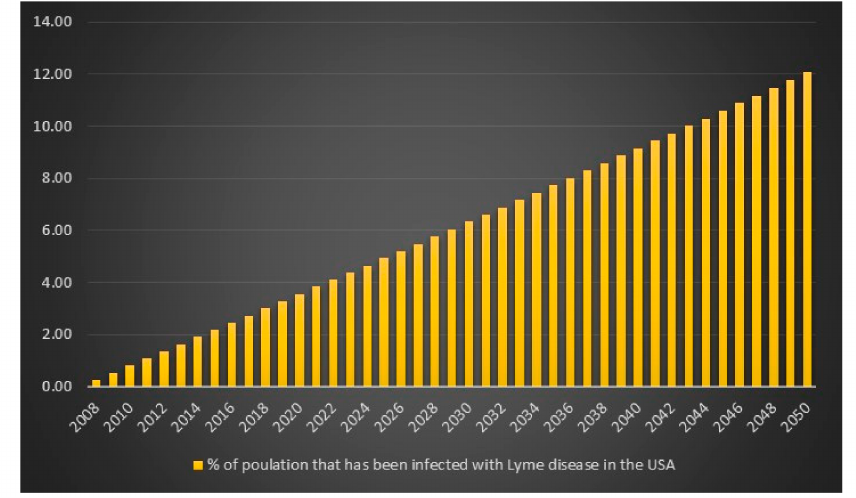
Figure 12. % of the population in the USA that have been infected with Lyme disease between the years 2008 to 2050.